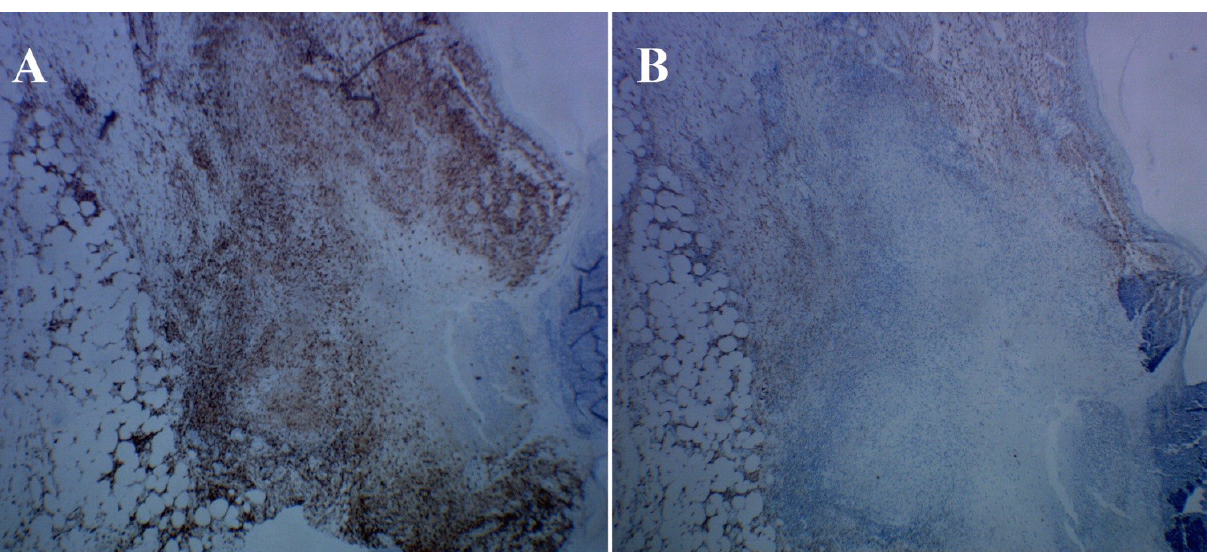
Figure 5. Immunohistochemistry for CD4 and factor XIII-A; ( A ) CD4 cells in the inflammatory infiltrate (immunohistochemistry for CD4); ( B ) necrobiotic collagen surrounded by factor XIII-A+ cells (immunohistochemistry for factor